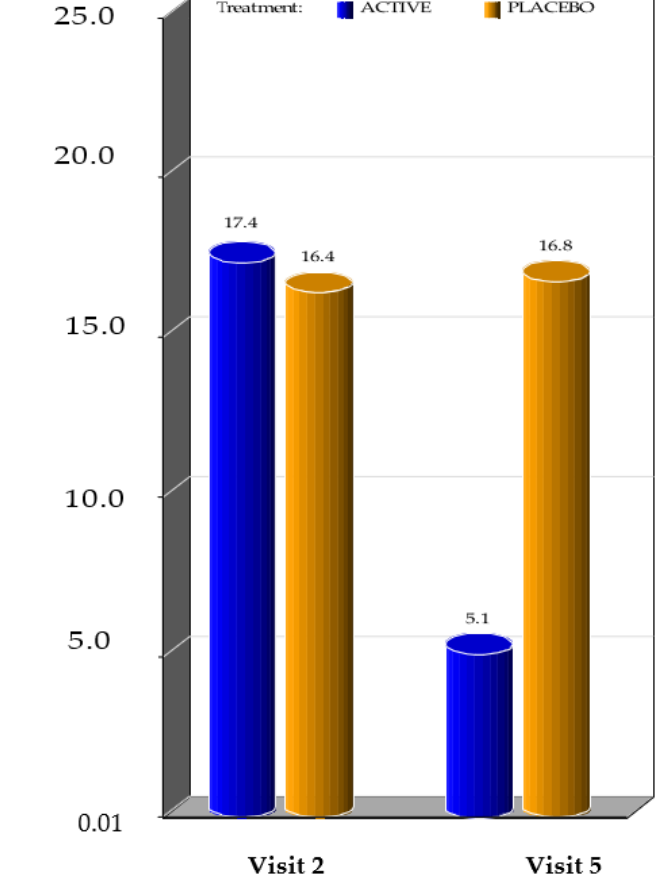
Figure 4. Mean value of ADHS at the first visit and at the visit 4 weeks after the beginning of the treatment. (Visit 2 corresponds to the visit performed on day 0, as Visit 1 corresponds to the day of laboratory tests).